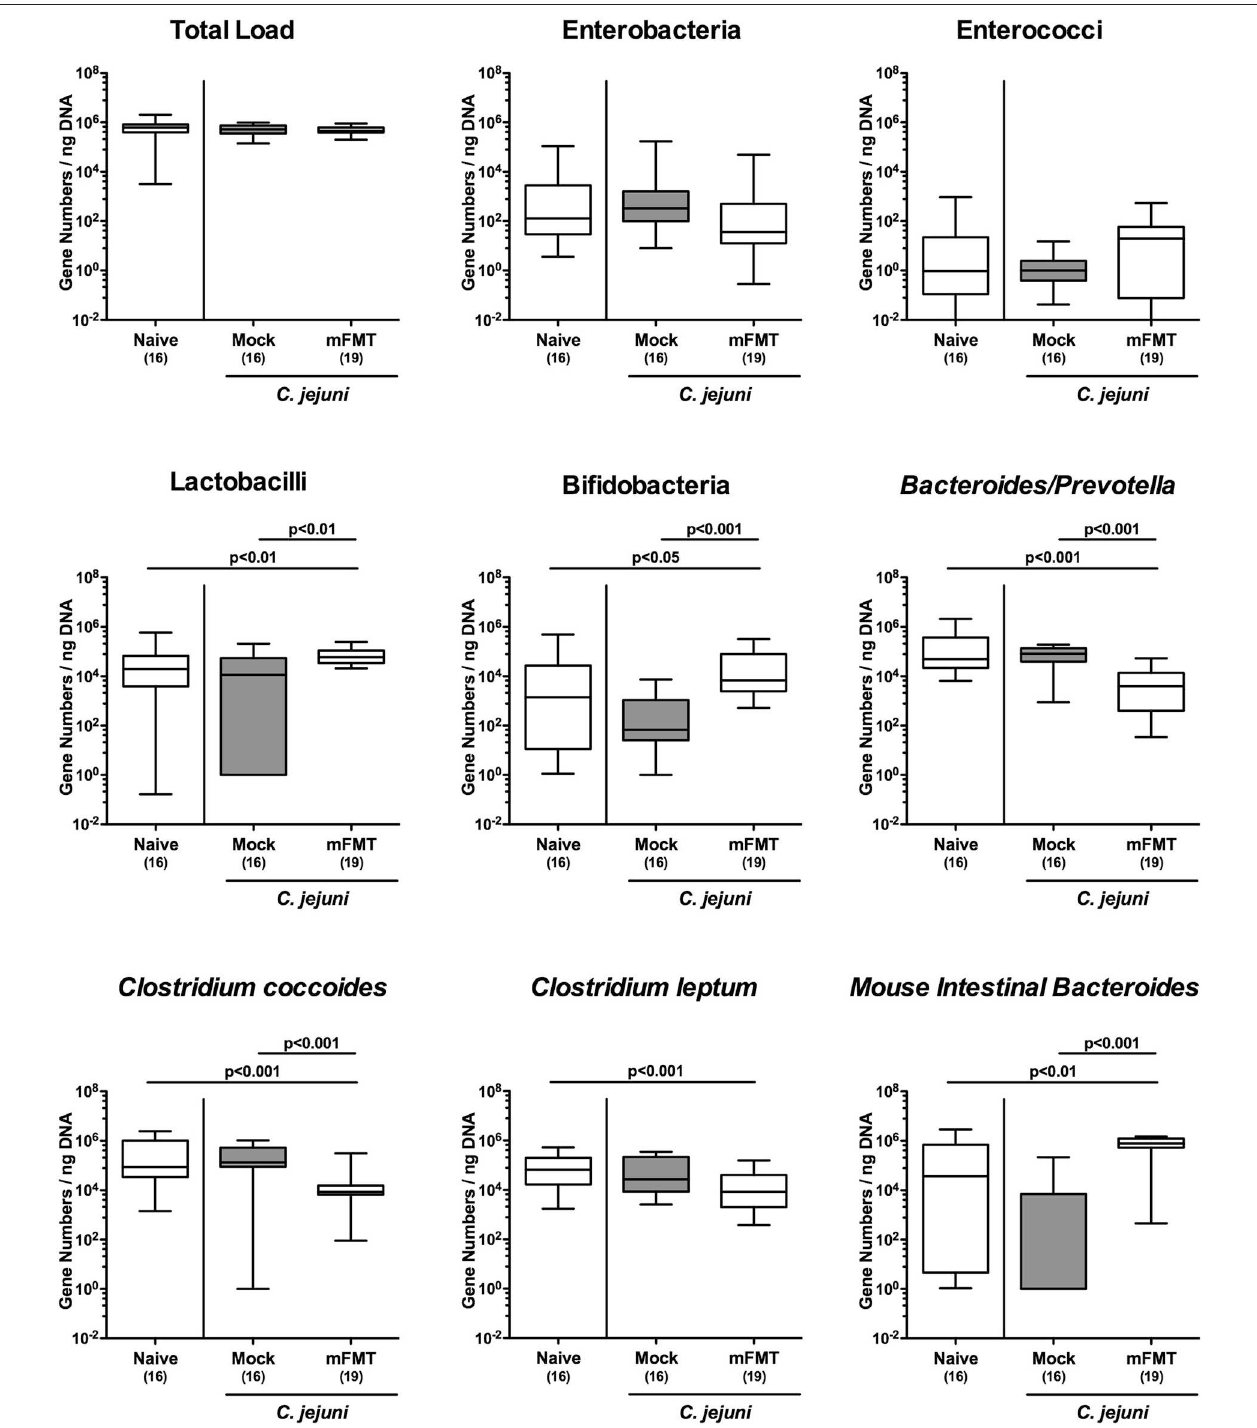
FIGURE 3 | Changes in intestinal microbiota composition following murine fecal microbiota transplantation of C. jejuni infected mice harboring a human gut microbiota. Mice with a human gut microbiota were perorally infected with C. jejuni on day (d) 0 and d1 and subjected to murine fecal microbiota transplantation (mFMT) or to mock treatment on d7, d8, and d9 post-infection (i.e., D0, D + 1, D + 2) or received vehicle (mock). Seven days later (i.e., D + 7), the fecal commensal microbiota composition was assessed applying culture-independent 16S rRNA methods quantitating the total eubacterial load and main bacterial groups as indicated (expressed as gene numbers per ng DNA). Box plots represent the 75th and 25th percentiles of medians (black bar inside the boxes). The total range and significance levels ( p -values) determined by the Kruskal-Wallis test and Dunn’s post-correction and numbers of analyzed animals (in parentheses) are indicated. Data were pooled from four independent